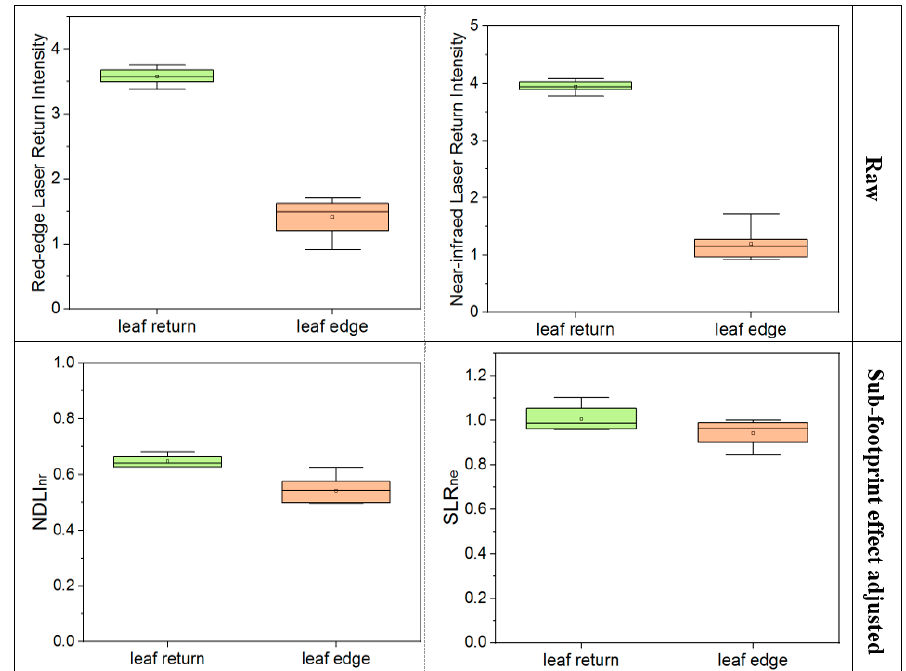
Figure 15. Spectral separability of leaf returns and mixed ‐ edge returns associated with the red ‐ edge (719 nm) and near ‐ infrared (784 nm) laser backscatter intensities; sub ‐ footprint effect adjusted with the normalized difference laser index (NDLI nr ) and sample laser ratio (SLR ne ).